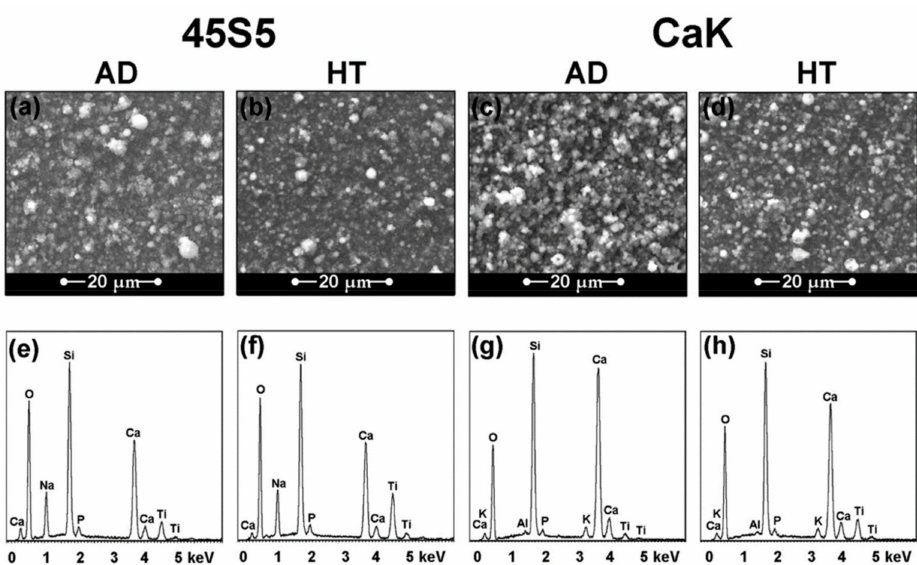
Figure 8. SEM images of as-deposited ( a , c ) and thermal annealed ( b , d ) coatings; results of EDX analysis on as-deposited ( e , g ) and thermal annealed ( f , h ) coatings. Reprinted with permission from [78]. © 2017 Elsevier.